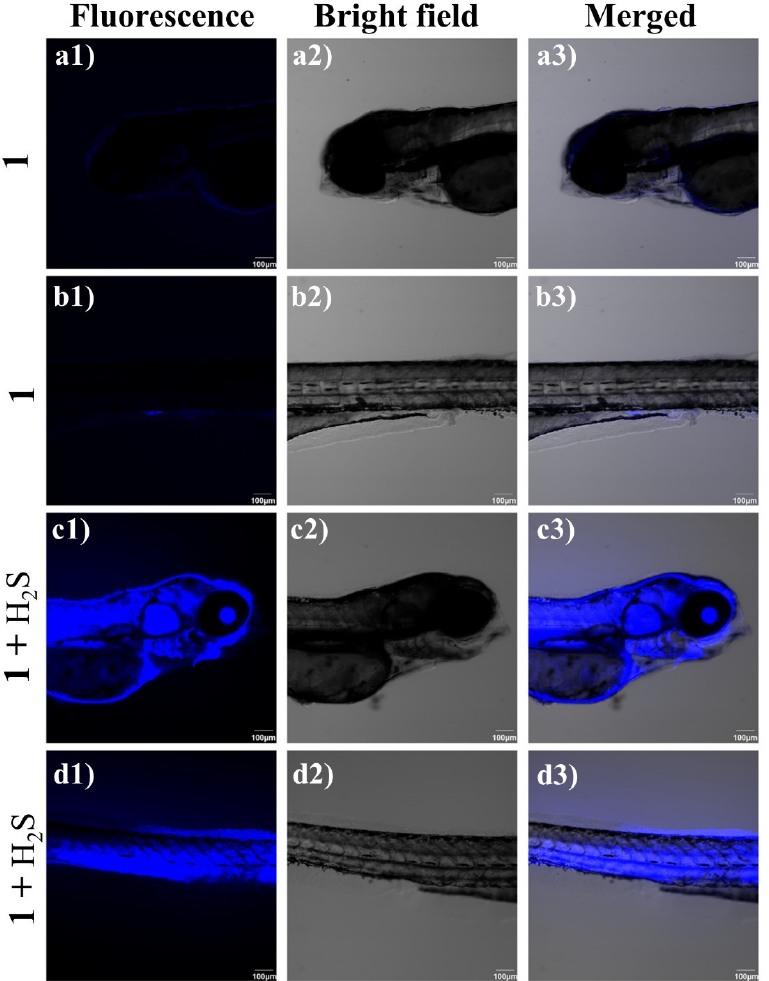
Figure 7. Confocal images of H 2 S in zebrafish. Zebrafish were fed with probe 1 (10 μM) and cultured for 30 min ( a1 – a3 , b1 – b3 ), followed by incubation with H 2 S for another 30 min ( c1 – c3 , d1 – d3